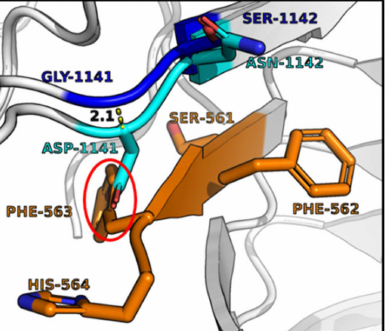
Figure 5. The anion of D1141 disrupts organization of the pi network of Phe563 in a modeled HCC/A4-LD4 of SV2C complex. The corresponding region of HCC/A4 (PDB:6F0P) was overlapped on the cocrystal of HCC/A1-LD4 of SV2C (PDB:5JLV). Note the extension of the carboxylate of D1141 into the pi network of LD4-Phe563 (red circle), while A4-Asn1142 and A1-Ser1142 are distanced from the SV2C β -strand.